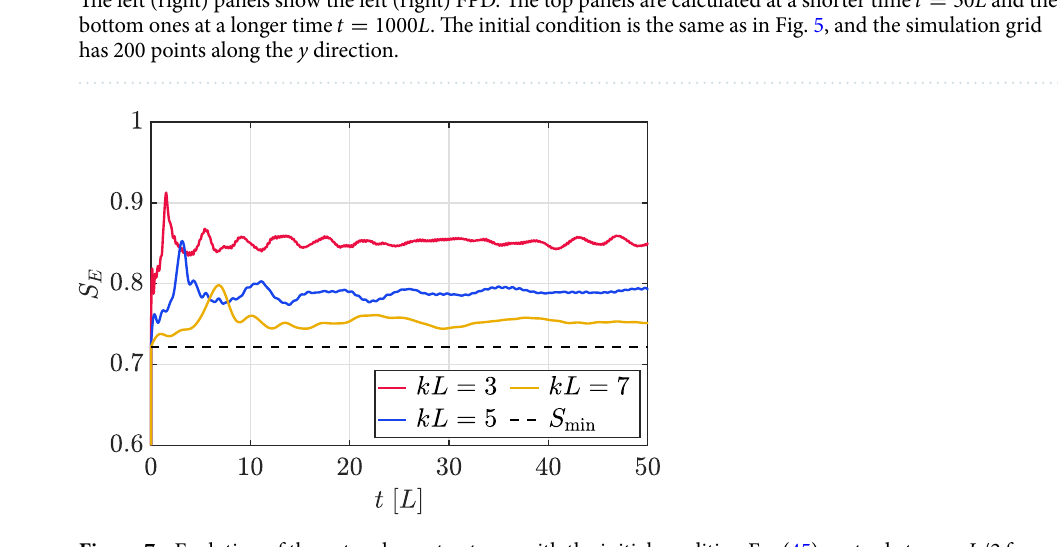
Figure 7. Evolution of the entanglement entropy with the initial condition Eq. (45) centred at y 0 different values of the warp coefficient and initial coin components C 0 minimum value the entropy can reach for very high values of kL , which is computed in the Supplementary Information. This simulation grid has 50 points along the y